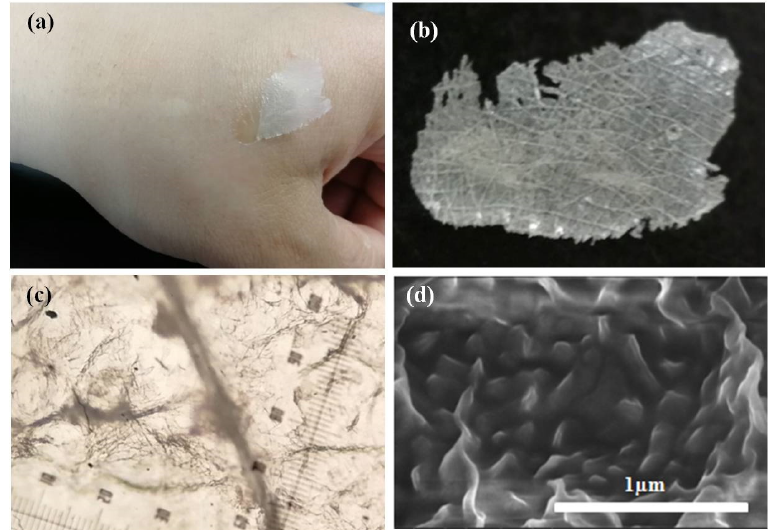
Figure 3. The appearance and properties of L-Bandage formed film. ( a ) Digital photograph of PVA/CHT/PHMB film on the surface of human skin; ( b ) digital photograph, ( c ) optical photograph, ( d ) SEM micrograph of PVA/CHT/PHMB film removed from the surface of human skin.